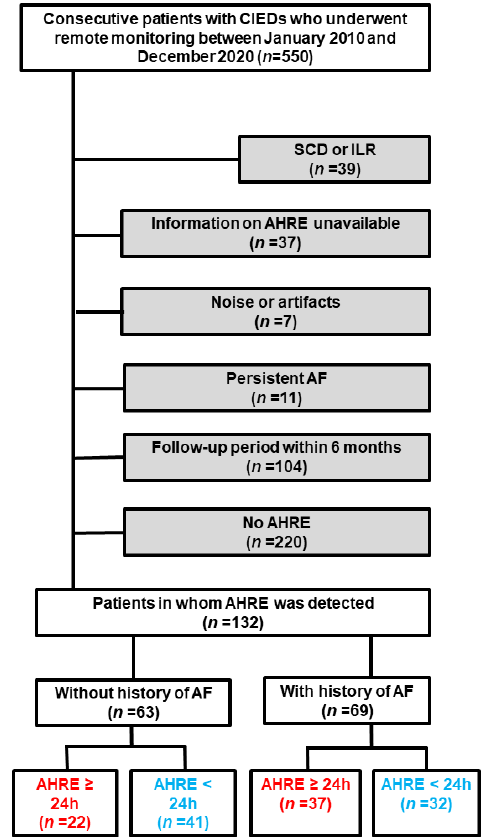
Figure 1. Flow diagram of the study. Red and blue texts indicated AHRE of ≥ 24 h and <24 h, respectively. Grey background indicated excluded patients. Blue texts indi AF, atrial fibrillation; AHRE, atrial high-rate episodes; CIED, cardiac implantable electronic device; ILR, implantable loop recorder; SCD, subcutaneous cardioverter-defibrillator.